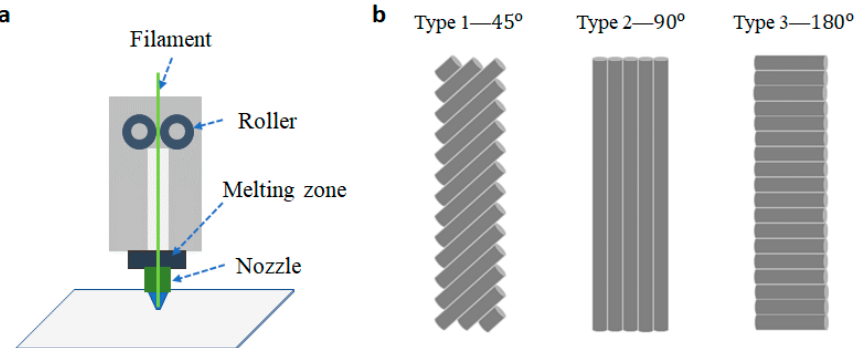
Figure 1. ( a ) Fused deposition modeling (FDM), ( b ) three structures (45°, 90°, 180°) of three-dimen- sional (3D) printing-line